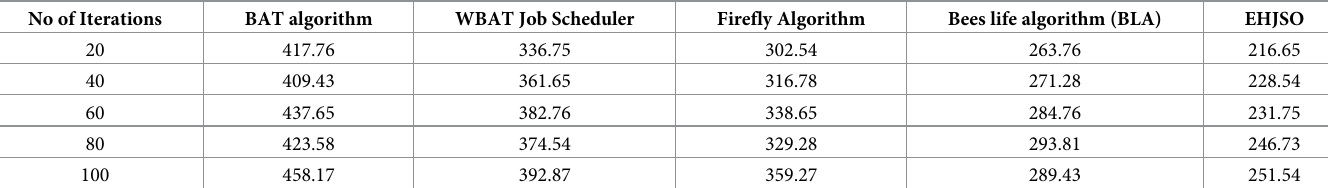
Table 3. Computation time analysis for EHJSO method with existing system. No of Iterations BAT algorithm WBAT Job